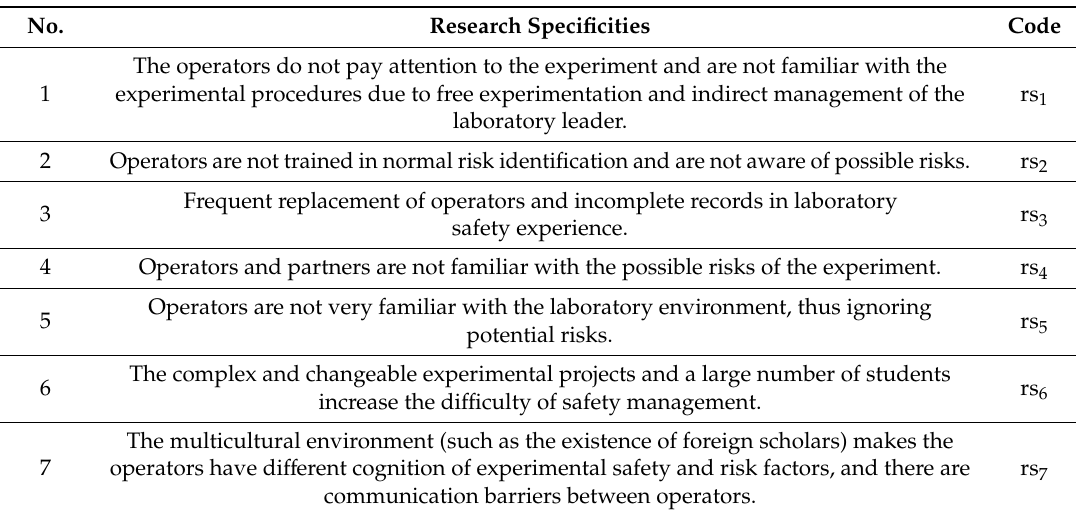
Table 2. Score of research